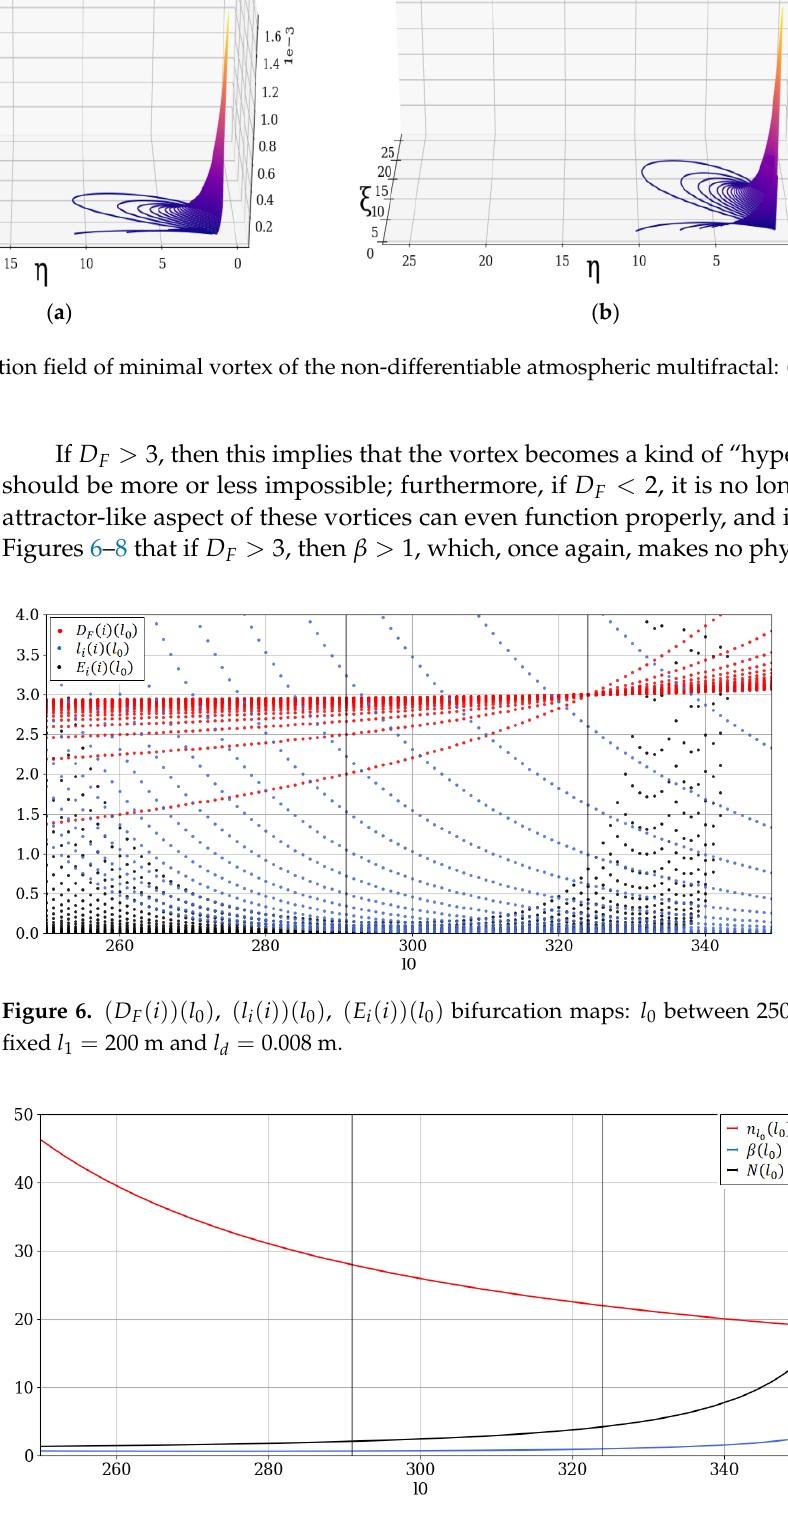
𝑙 𝑑 = 0.008 m . ,𝛽,𝑁 as functions of 𝑙 0 : 𝑙 0 between 250 and 350 m , with a fixed 𝑙 1 = 200 m and Figure 7. 𝑛 𝑙 Figure 7. n l , β , N as functions of l 0 : l 0 between 250 and 350 m, with a fixed l 1 = 200 m and 0 0 𝑙 𝑑 = 0.008 m . l d = 0.008